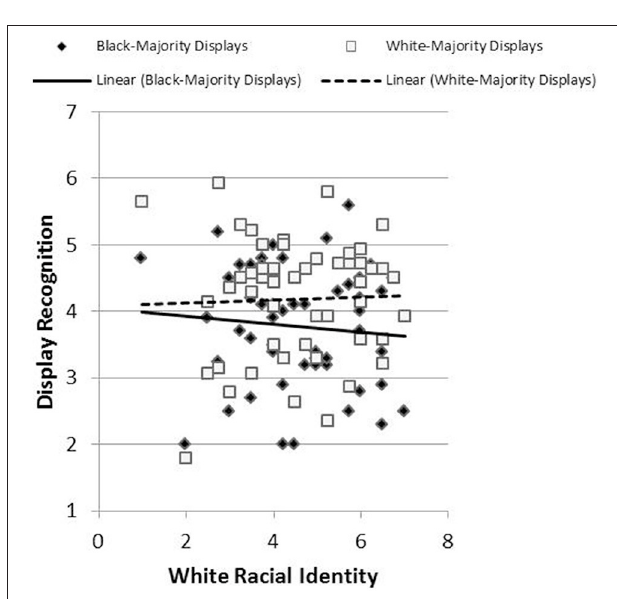
FIGURE 7 | Relationship between racial identity and display recognition among Black-Majority and White-Majority Black History displays, Study 2.